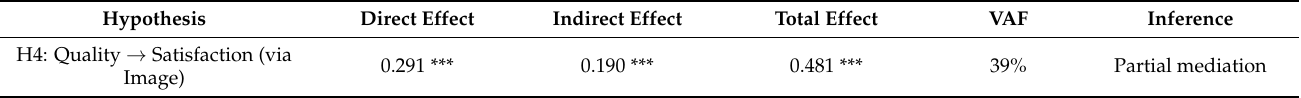
Table 6. Results of the analysis for mediating effect in the hypothesized